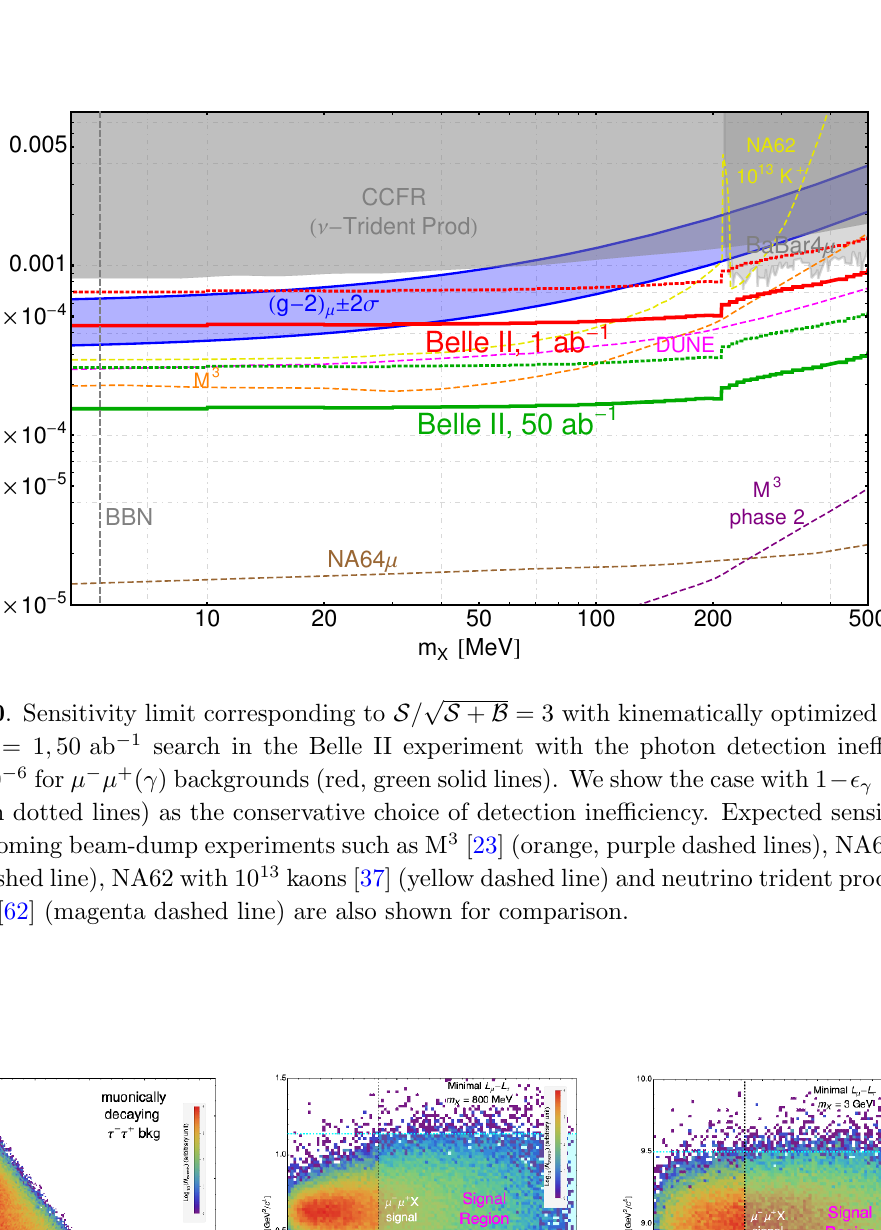
(cid:22) (cid:0) (cid:22) + (cid:23)(cid:23) (cid:22) (cid:23) (cid:22) (cid:23) ) and (cid:22) (cid:0) (cid:22) + X; X !